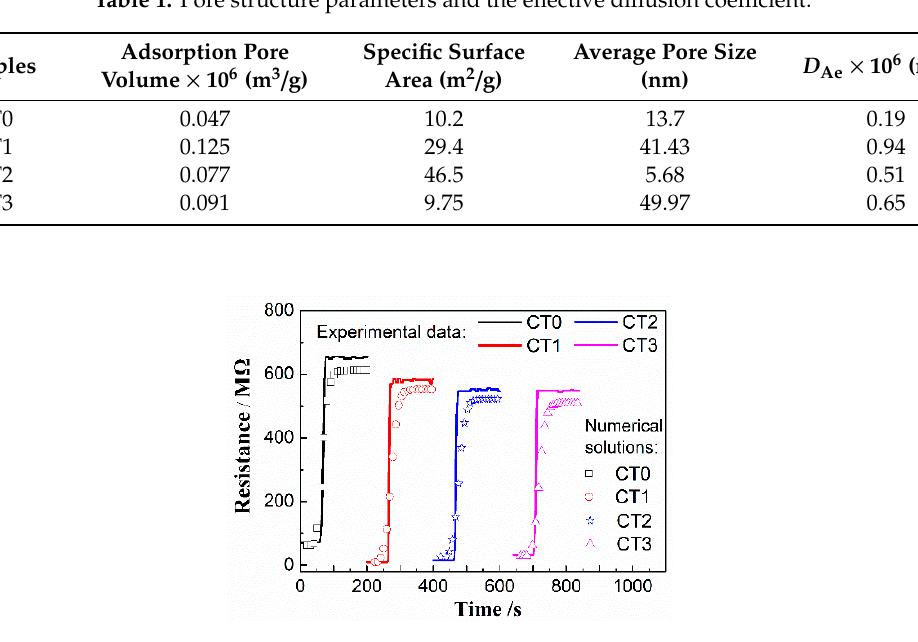
Figure 7. Comparison of the calculated results with the experimental data for resistances of samples CT0, CT1, CT2, and CT3 towards 100 ppm ethanol at 400 °C.